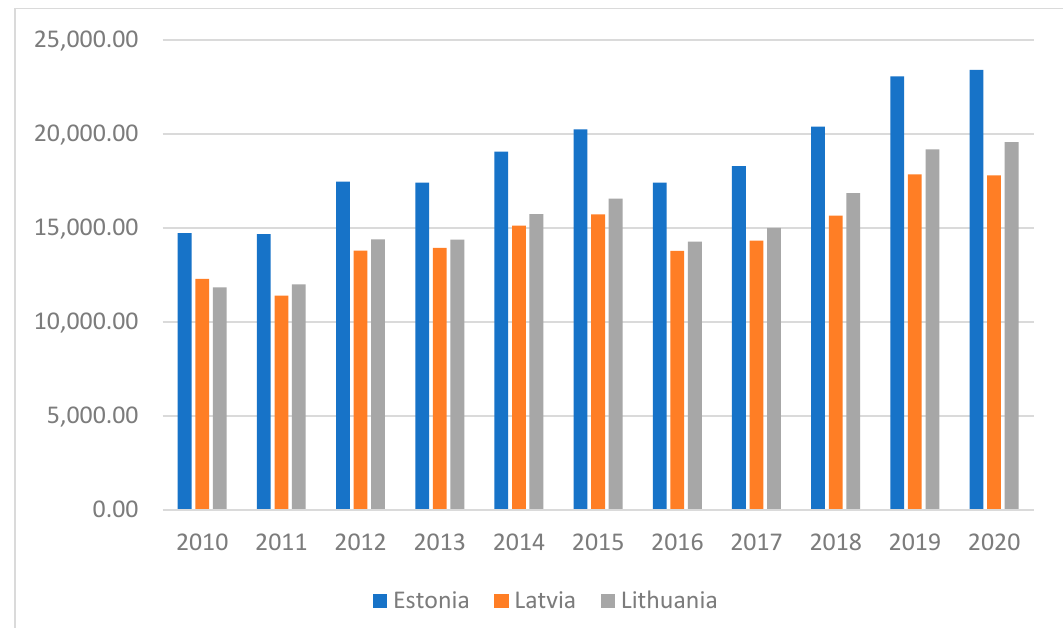
Figure 2. GDP per capita dynamics in the Baltic states over the period of 2010–2020.